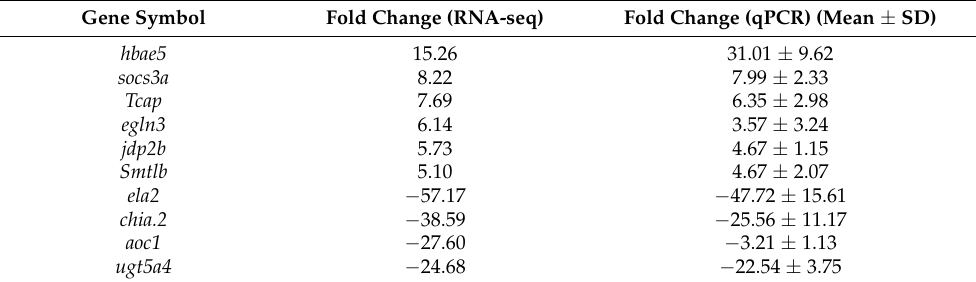
Table 4. qPCR-based validation of ten randomly selected DEGs from transcriptome